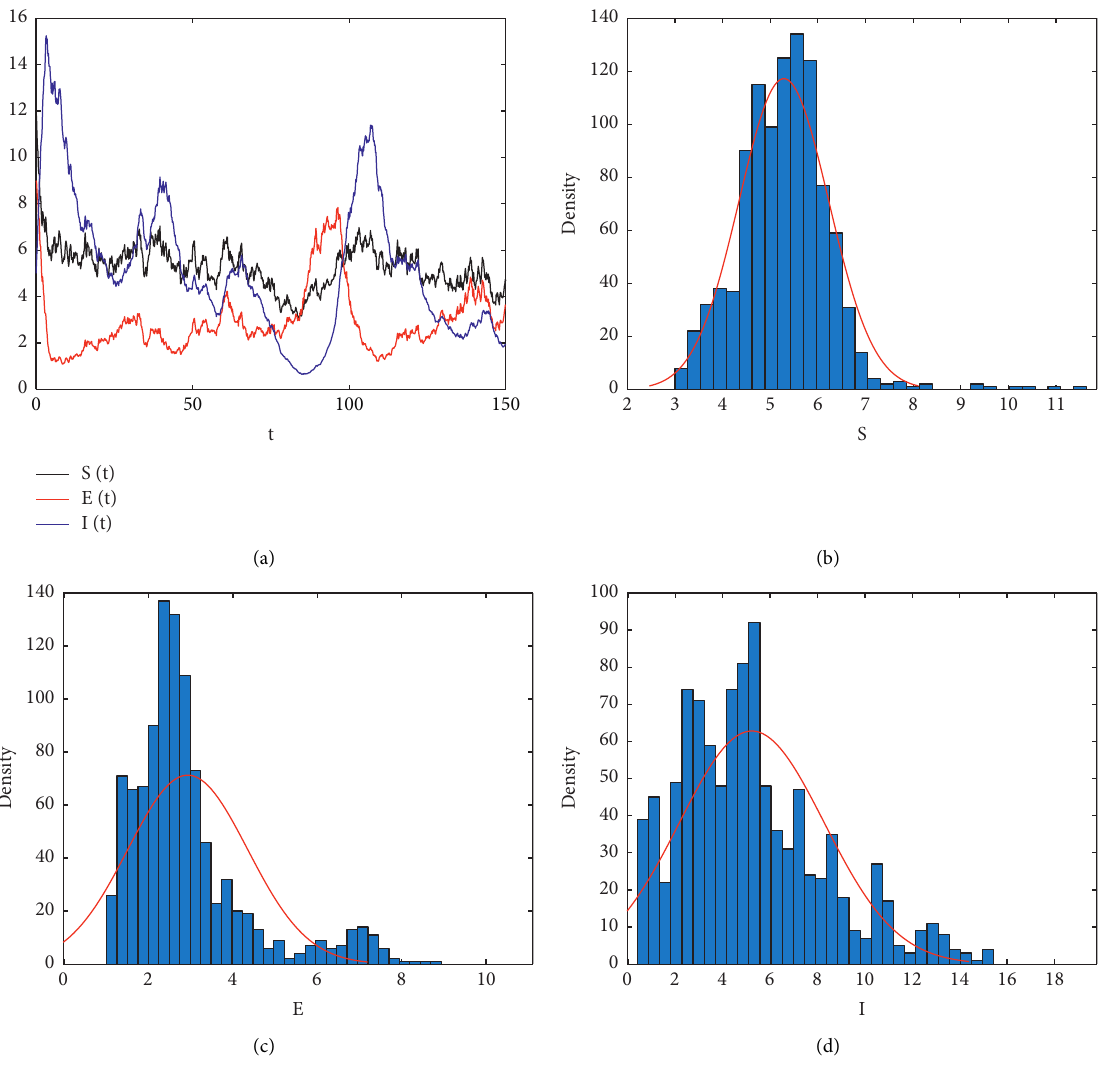
Figure 3: ( a ) is the solution of the stochastic model (2). ( b ) , ( c ) , ( d ) , respectively, represent the density function of S, E, I in model